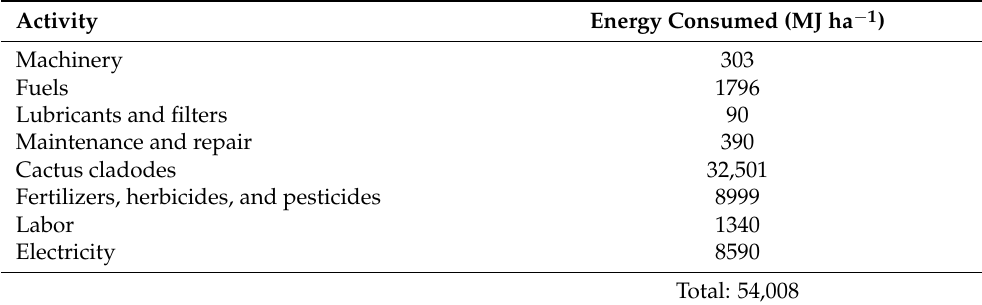
Table 9. Energy consumed (MJ ha − 1 ) in the production of cactus biomass in the Brazilian North- east region.